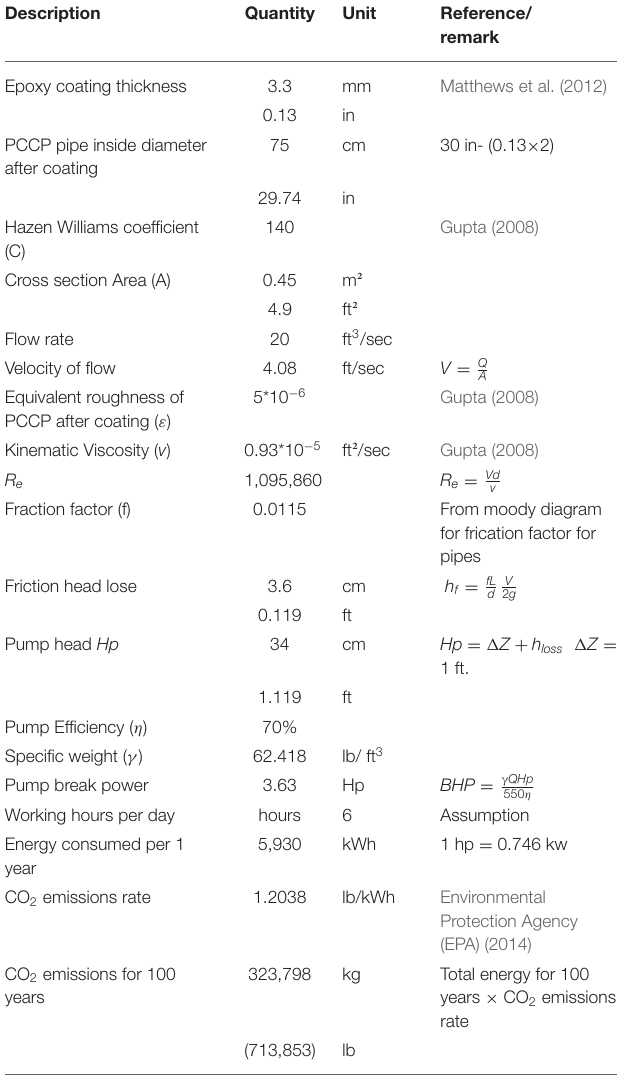
TABLE 5 | Carbon emissions during the operation phase of PCCP pipe after the epoxy coating.